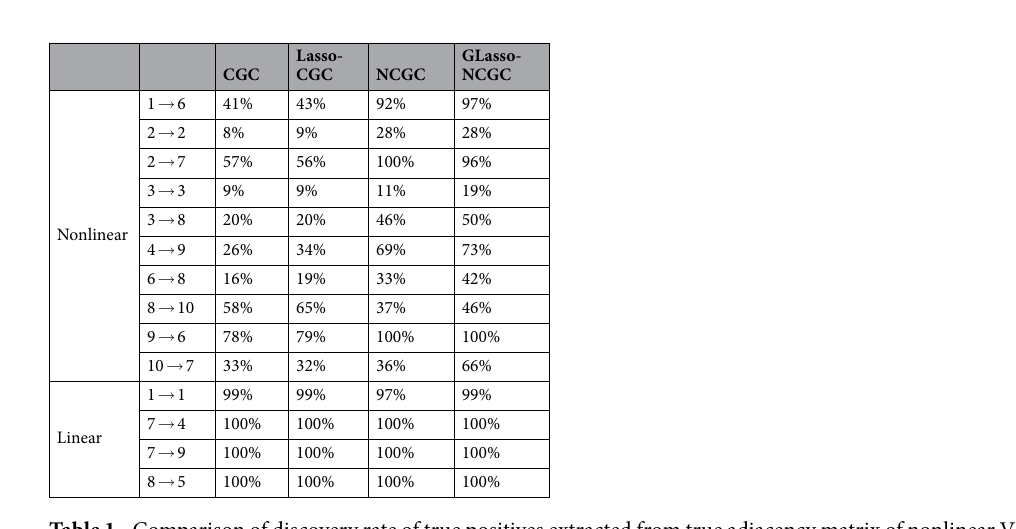
Table 1. Comparison of discovery rate of true positives extracted from true adjacency matrix of nonlinear VAR model.